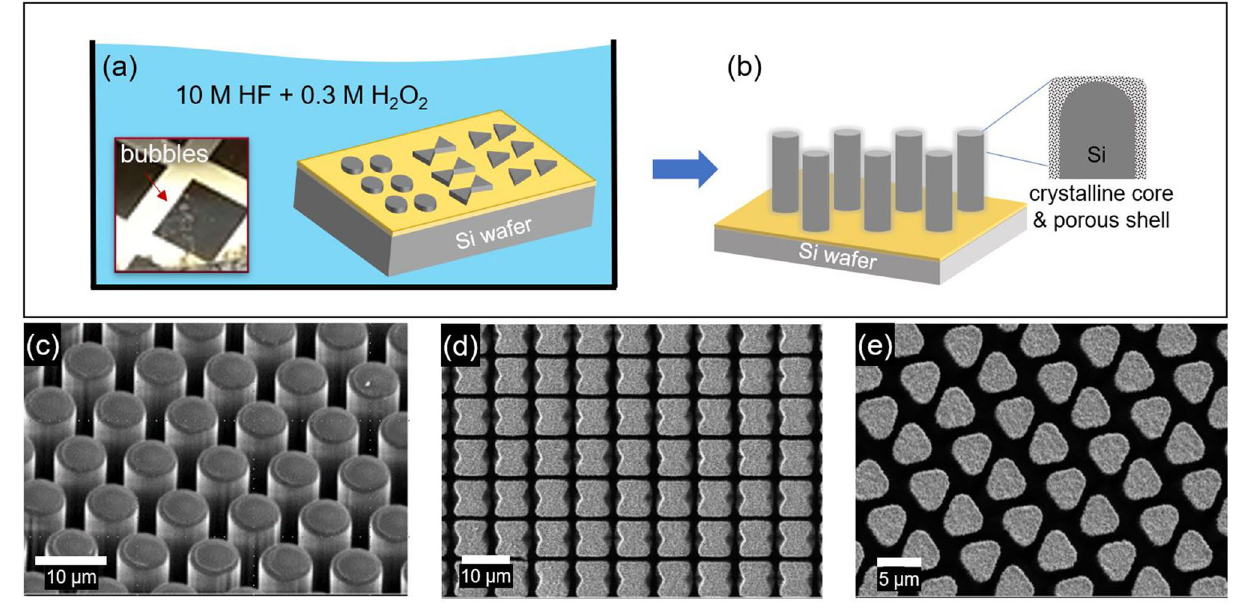
Figure 1. Schematics of ( a ) and ( b ) illustrate the metal-assisted chemical etching (MACE) processes to fabricate 3D Si micropillar arrays. The H 2 bubbles arise from the Si substrate in the etchant due to the anodic reaction (Eq. 2). Scanning electron microscope (SEM) image of a portion of the MACE fabricated 3D structures with an array pattern of circles ( c ), ribbons ( d ), and triangles ( e ). Comprehensive optoelectronic characterizations were performed on the pillar arrays in ( c ) that have a nominal diameter of 8 µm and a height of 20 µm, and the distance between the pillars is about 3.5 µm.